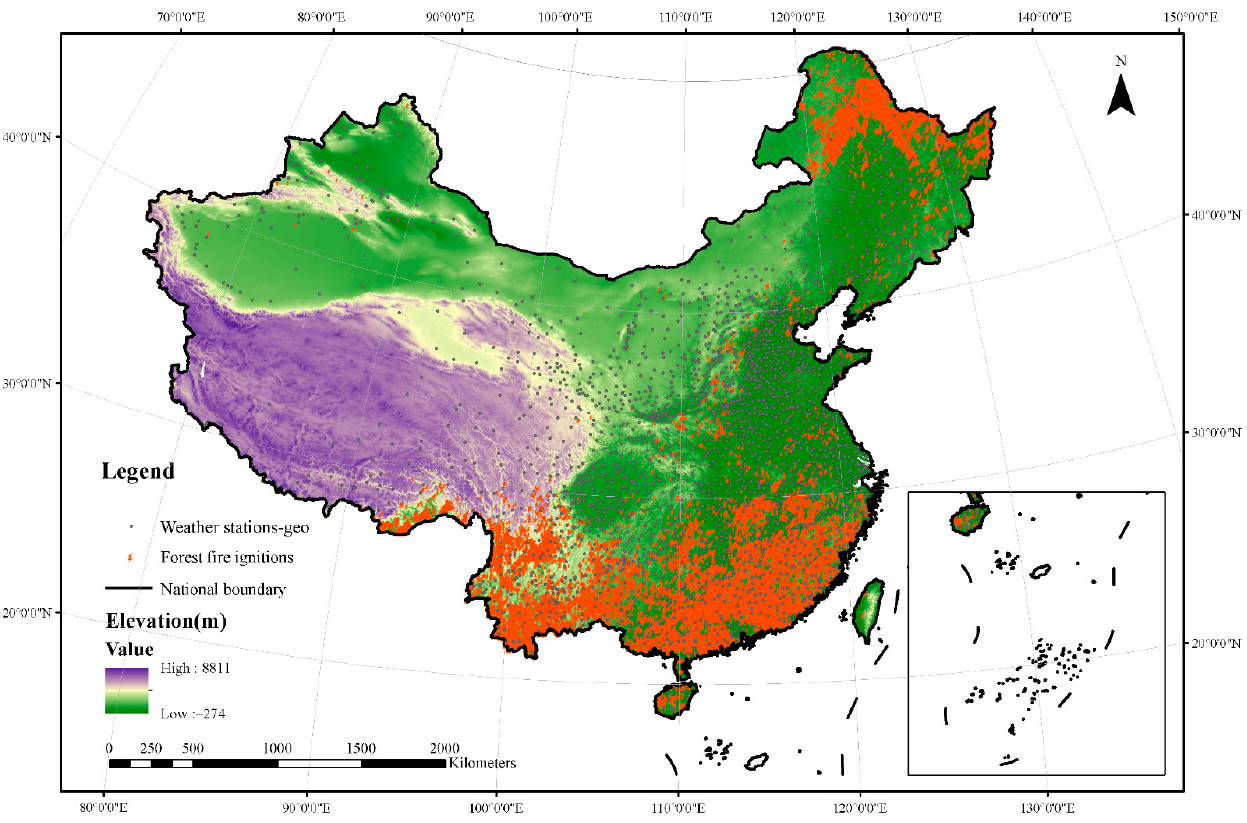
Figure 1. Map of the study area.